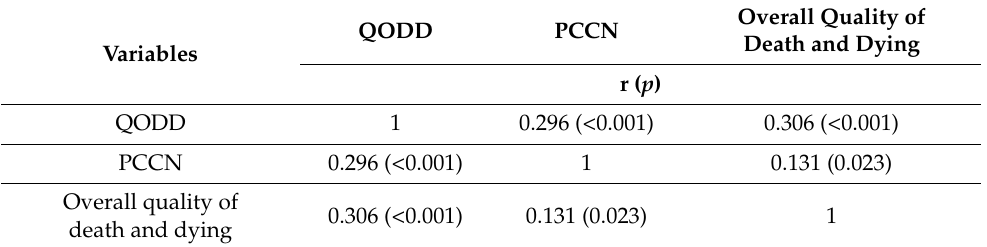
Table 4. The correlations among QODD, PCCN and overall quality of death (N =